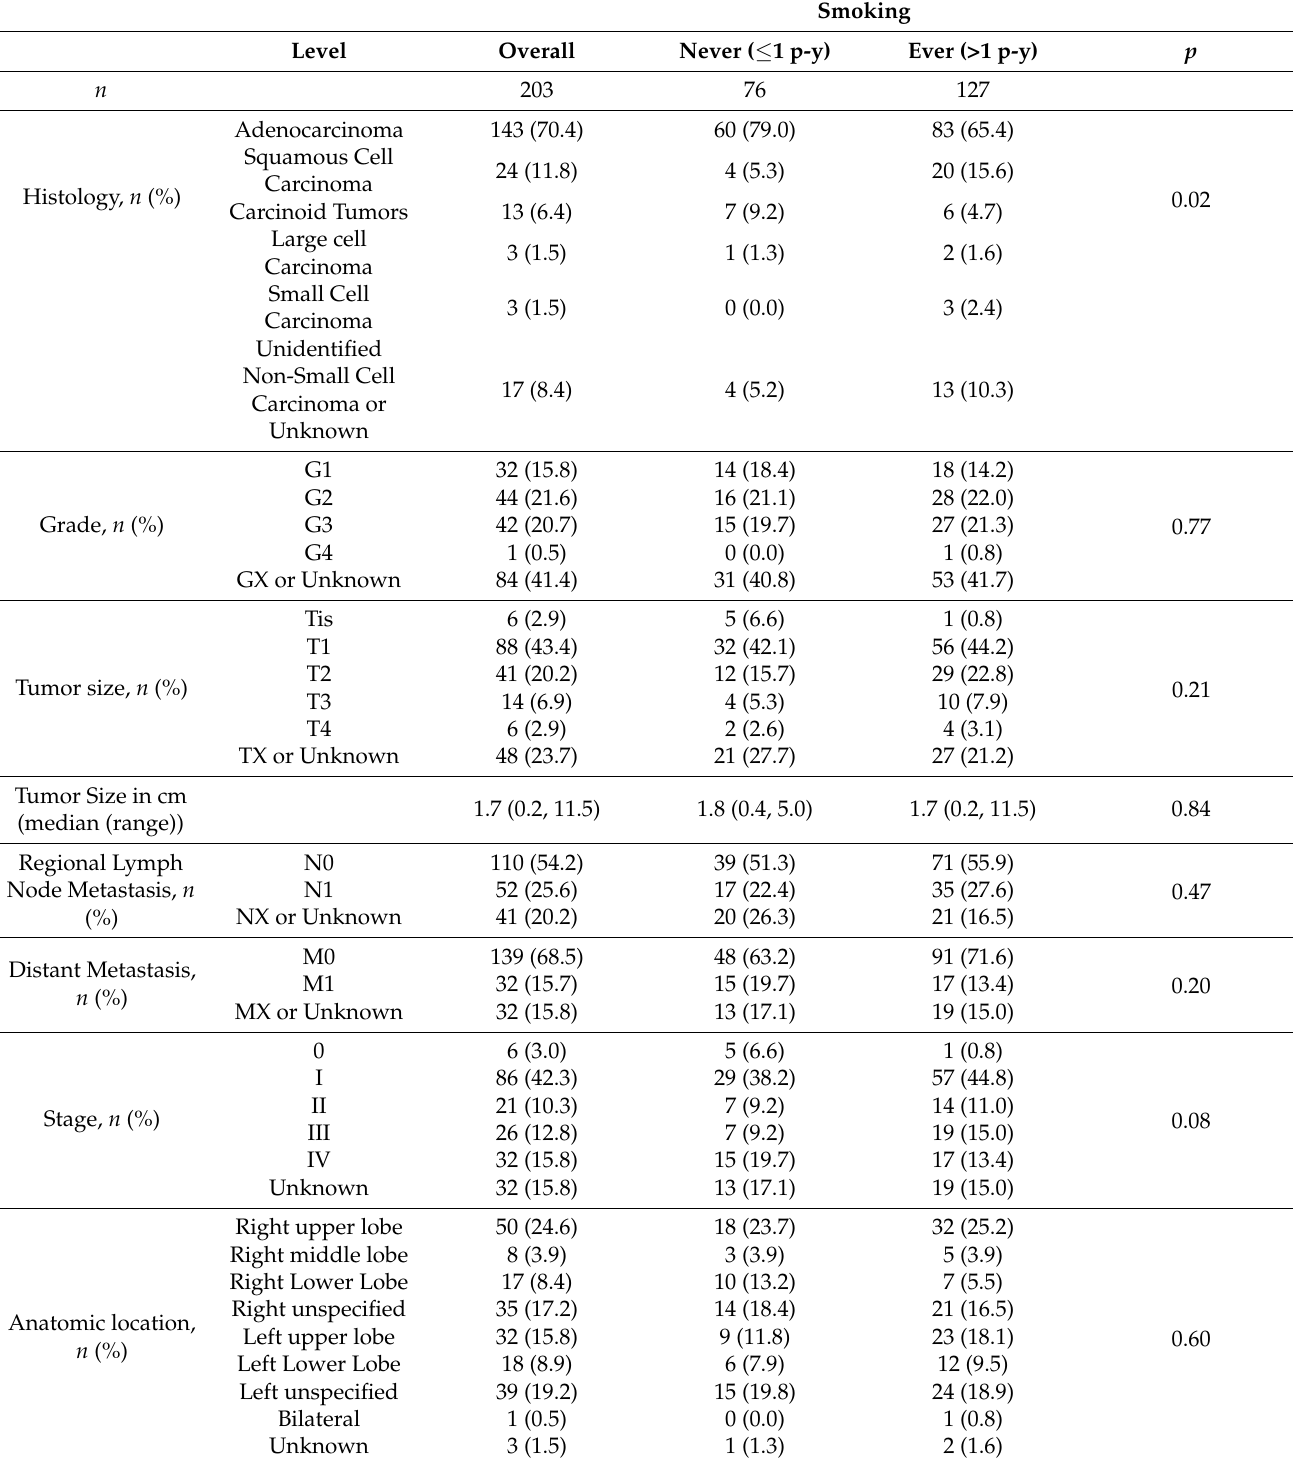
Table 2. Characteristics of lung cancers in the WTC Environmental Health Center with smoking